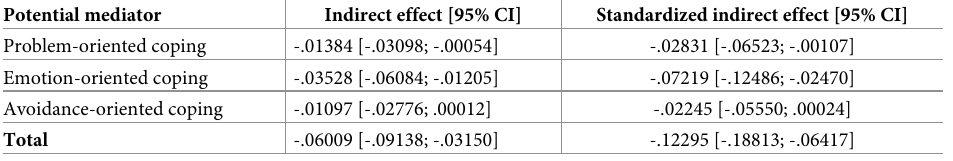
Table 2. Indirect effects for mediational relations between the impact of the disease, coping strategies, and self- management in people with MS.